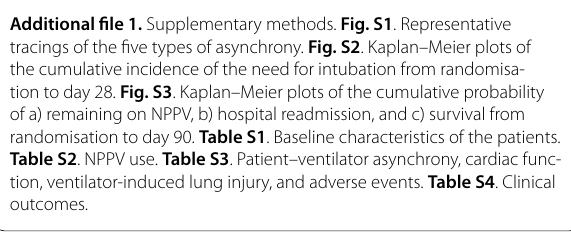
Table S2 . NPPV use. Table S3 . Patient–ventilator asynchrony, cardiac func- tion, ventilator-induced lung injury, and adverse events. Table S4 . Clinical